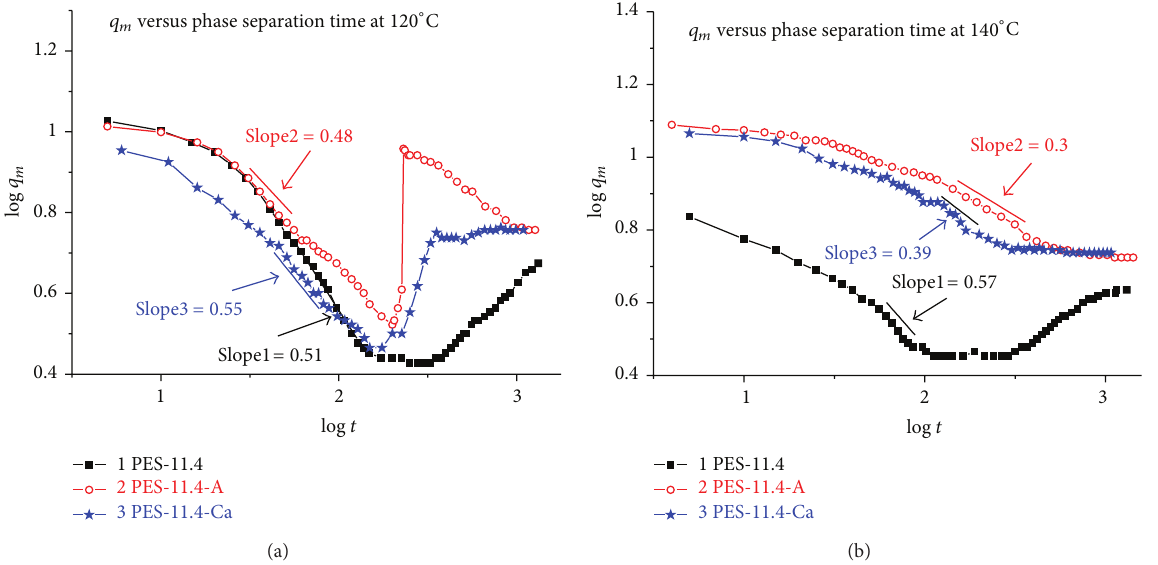
Figure 7: The changes of peak scattering vector, 𝑞 𝑚 , versus time of the blends of 11.4wt% PES with and without fillers. (a) Cured at 120 ∘ C, (b) cured at 140 ∘ C.